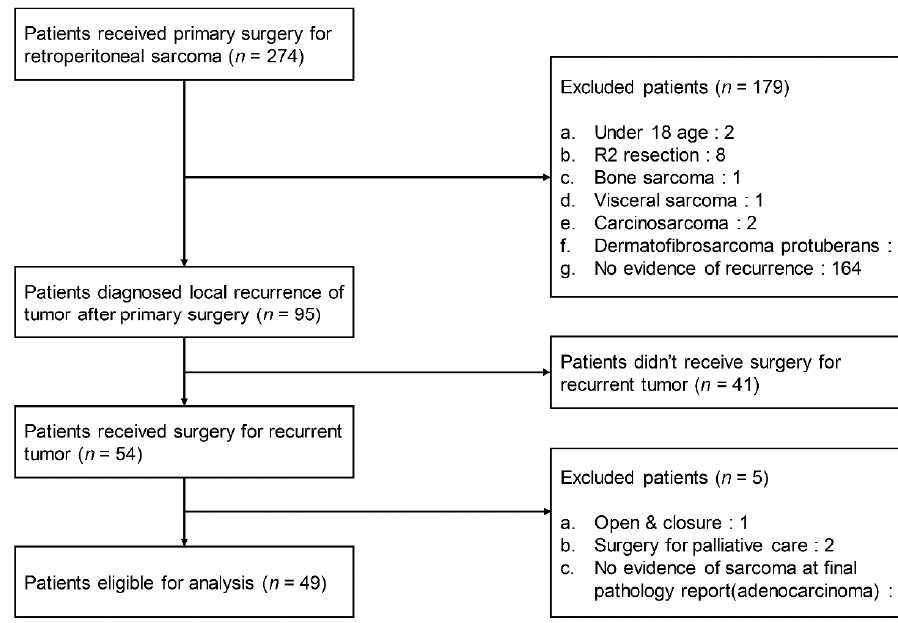
Figure 1. Flow diagram showing the selection